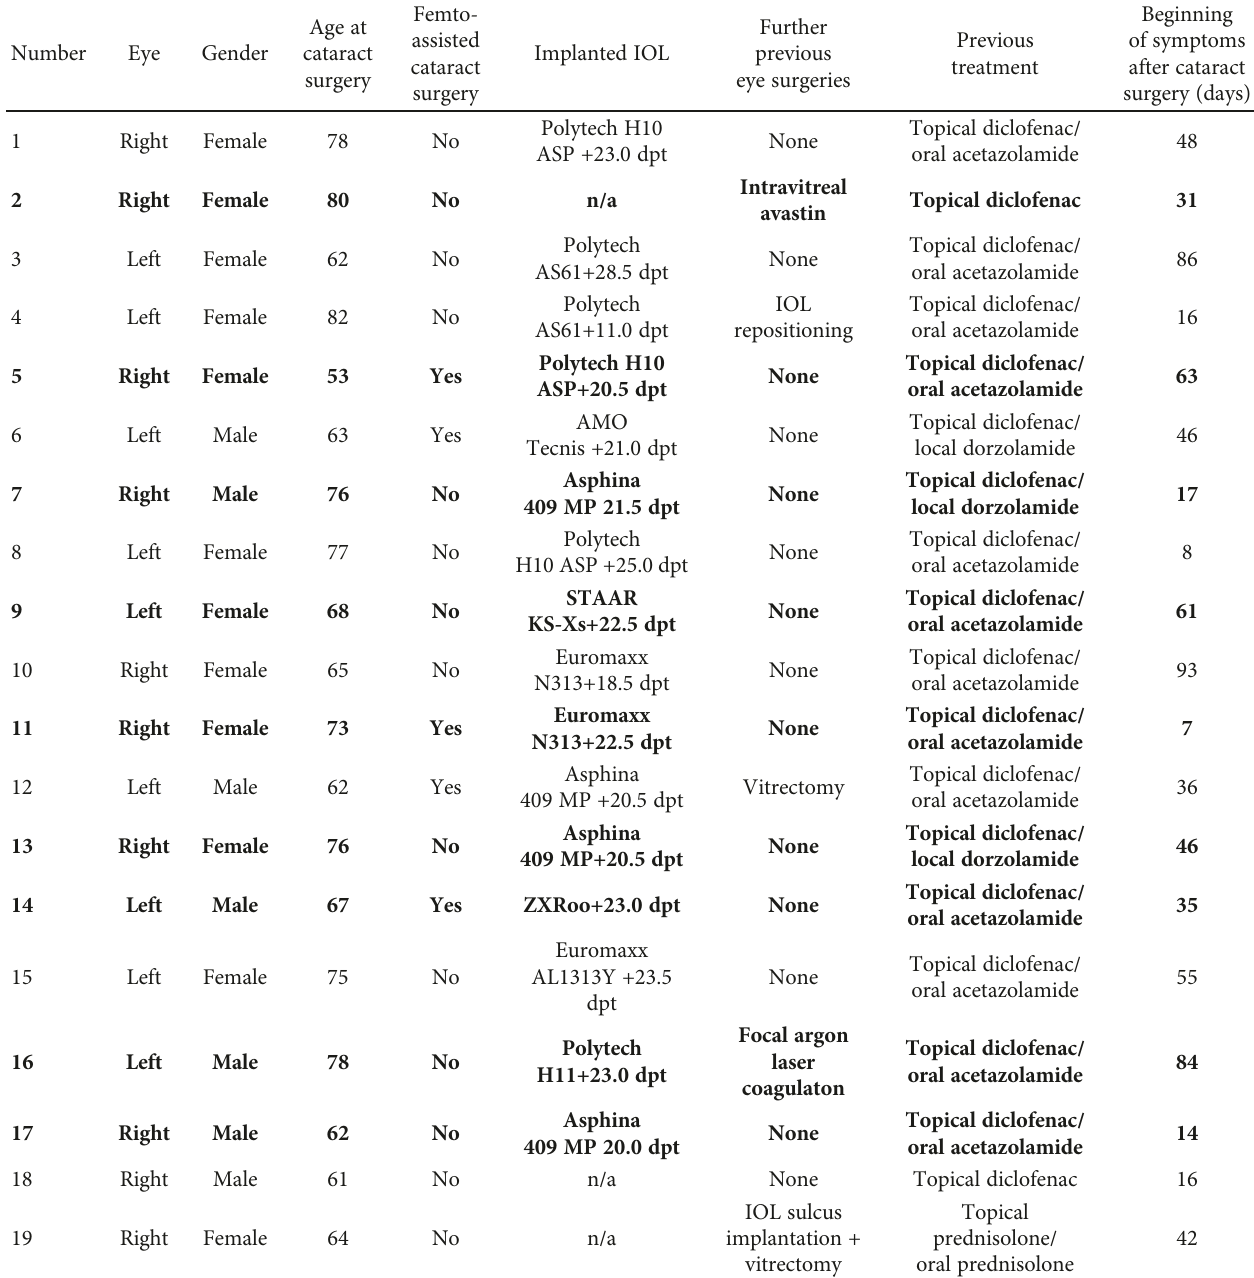
Table 1: Demographic and anamnestic data, follow-up times and safety fi